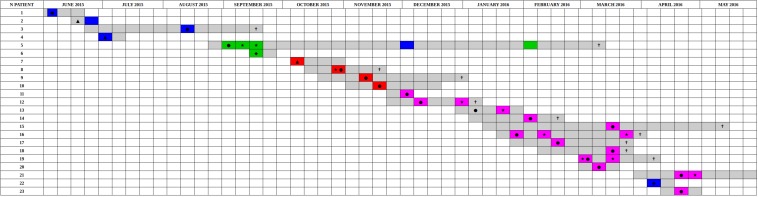
Timeline of the presence of carbapenem-resistant Klebsiella pneumoniae positive patients in the ICU in the period from June 2015 to May 2016. The periods of hospitalization are colored in gray. The other colors identify the sequenced samples based on genomic characterization. The colors green, red, and violet correspond to the three clusters identified based on SNPs distance, are reported sporadic cases in blue. Samples obtained from clinical infections (not surveillance swabs) are indicated by stars. The crosses indicate patients death. Black circles indicate the first positive CRKP rectal swab for each patient, negative at the admission. Black triangles indicate the first positive CRKP rectal swab for patients already CRKP-colonized at the admission time into the hospital. Black diamonds indicated the patients that became positive in other hospital wards.